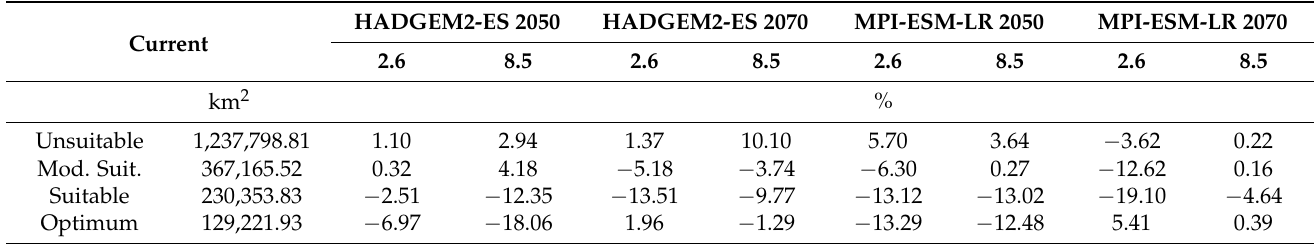
Table 3. Percentage change in fig crop area under different climatic